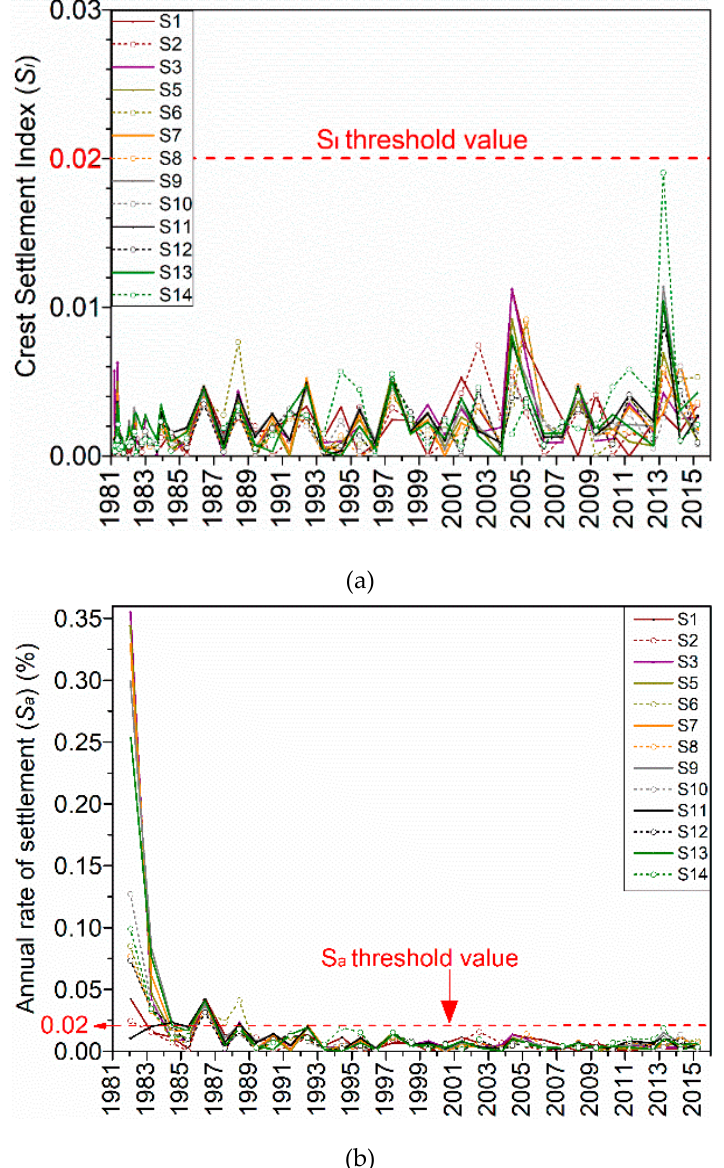
Figure 5. Crest settlements: ( a ) Settlement Index S I and ( b ) Annual rate of settlement.